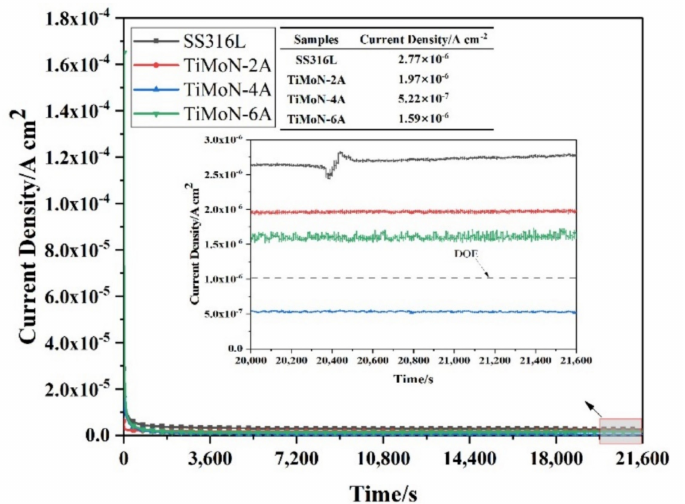
Figure 5. Potentiostatic polarization curves of SS316L and TiMoN coatings under simulated PEMFC cathode